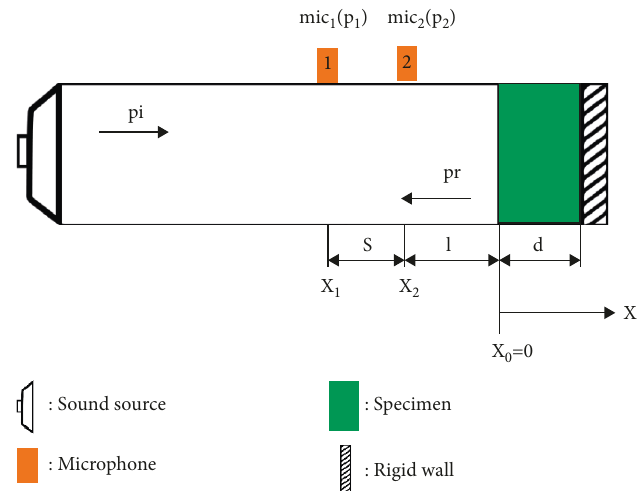
Figure 2: Impedance tube